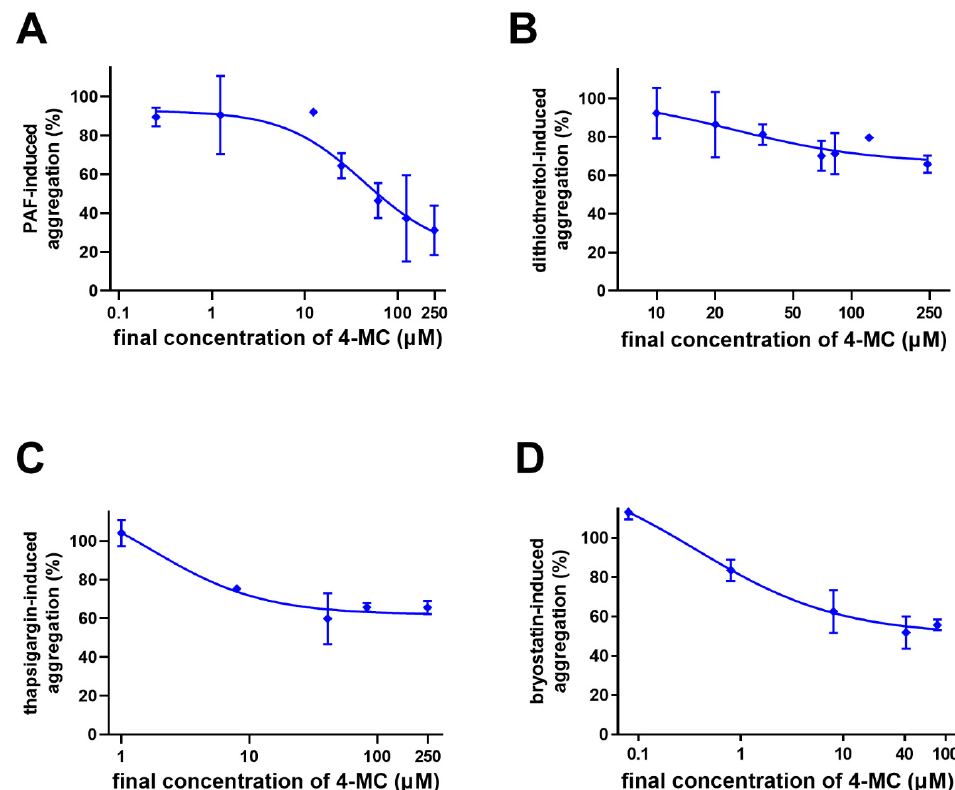
Figure 4. Investigation of the mechanism of the action of 4-methylcatechol (4-MC). In each of the experiments, 4-MC was incubated for 3 min with either blood or platelet-rich plasma (PRP), and aggregation was triggered afterward by the addition of an inducer. ( A ) The effect of 4-MC on platelet-activating factor 16 (PAF)—induced aggregation; aggregation was initiated by adding PAF (the final concentration in PRP was 40 nM). ( B ) The effect of 4-MC on dithiothreitol-induced aggregation in whole human blood; aggregation was initiated by adding dithiothreitol at a final concentration of 410 µ M. ( C ) The effect of 4-MC on thapsigargin-induced aggregation in whole human blood; aggregation was initiated by adding thapsigargin (the final concentration varied from 83 to 165 nM according to calibration in each individual donor). ( D ) The effect of 4-MC on bryostatin (8 nM)—induced aggregation in human whole